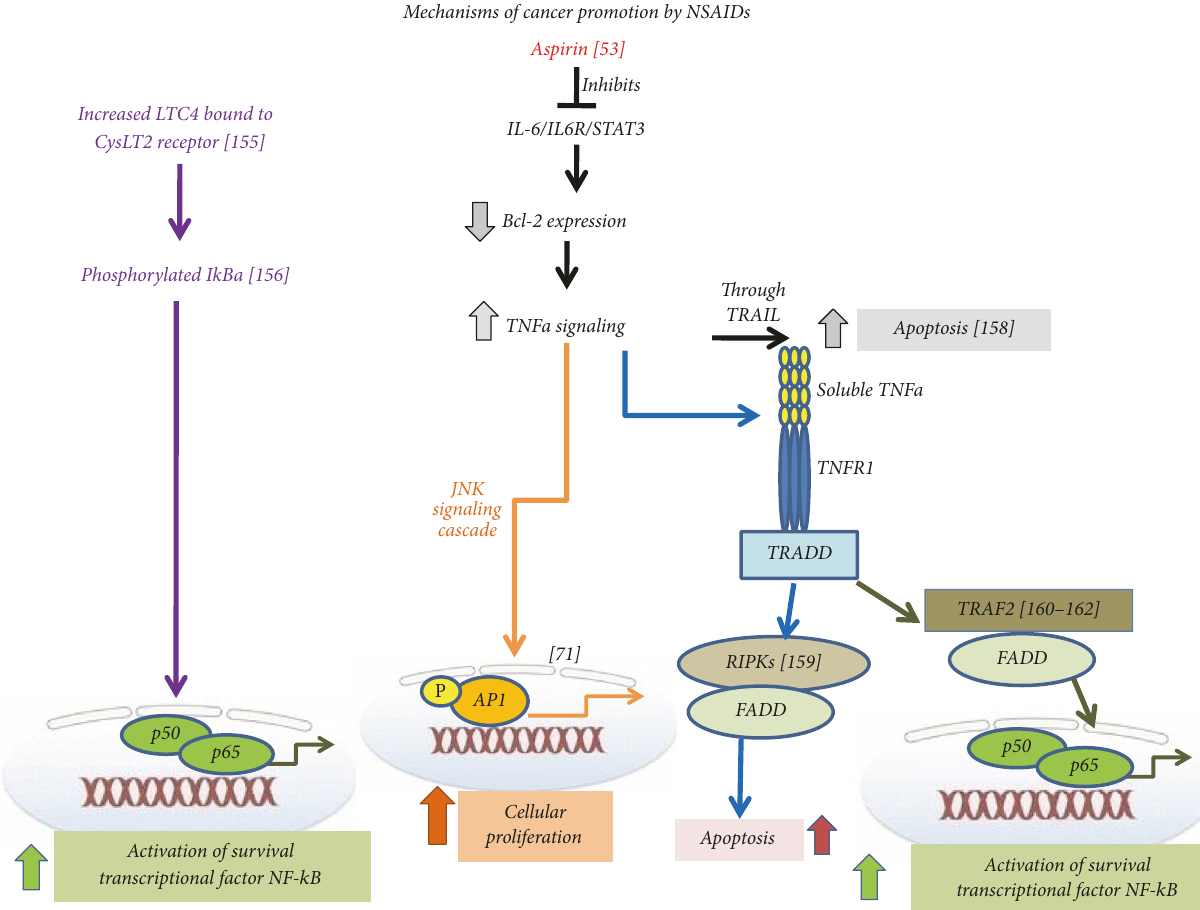
Figure 5: Molecular pathways that may contribute to promoting cancer by NSAID use [155–158, 160–163]. LTC 4 and TNF a may activate transcription factor NF-kB and increase cellular proliferation by concurrent pathways that otherwise induce apoptosis.